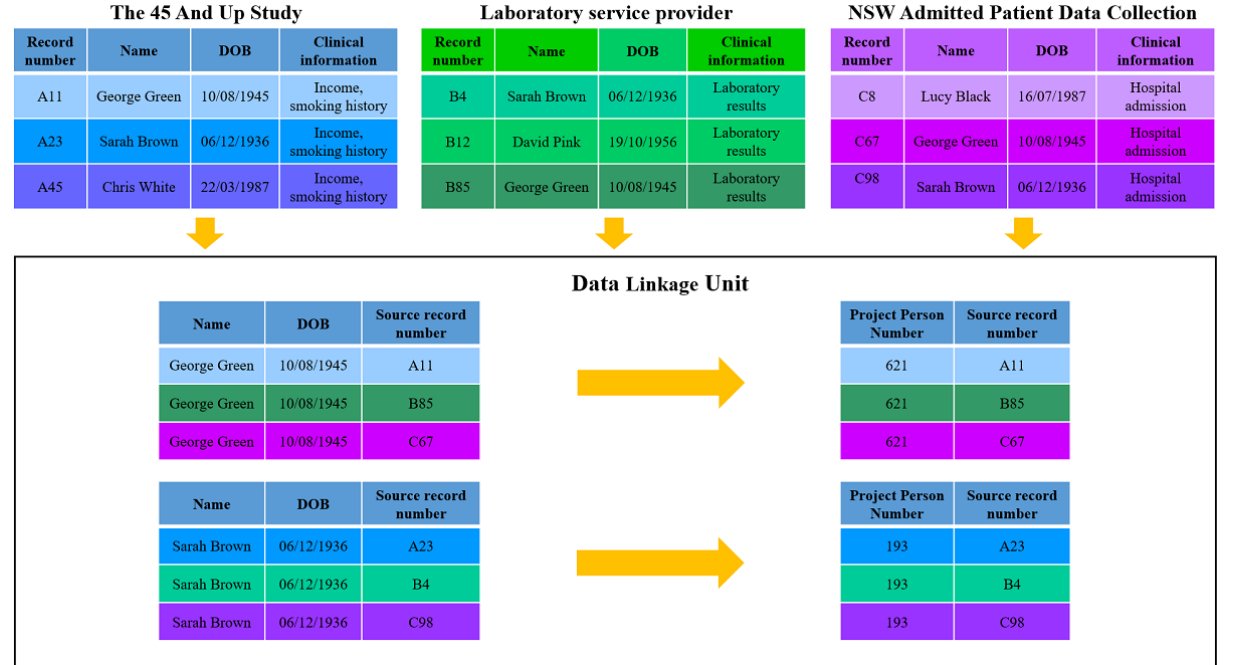
Figure 2. A schematic diagram of the linkage process: Stage 1. Each data custodian provides the Centre for Health Record Linkage (CHeReL, a data linkage unit) with relevant personal information of individuals who have accessed their service, together with their unique record number. The names and details used in the figure are fictitious and do not relate to any participants of the 45 and Up Study. The CHeReL uses an algorithm to match individuals to participants of the 45 and Up Study and assigns a project-specific person number to each individual. DOB: date of